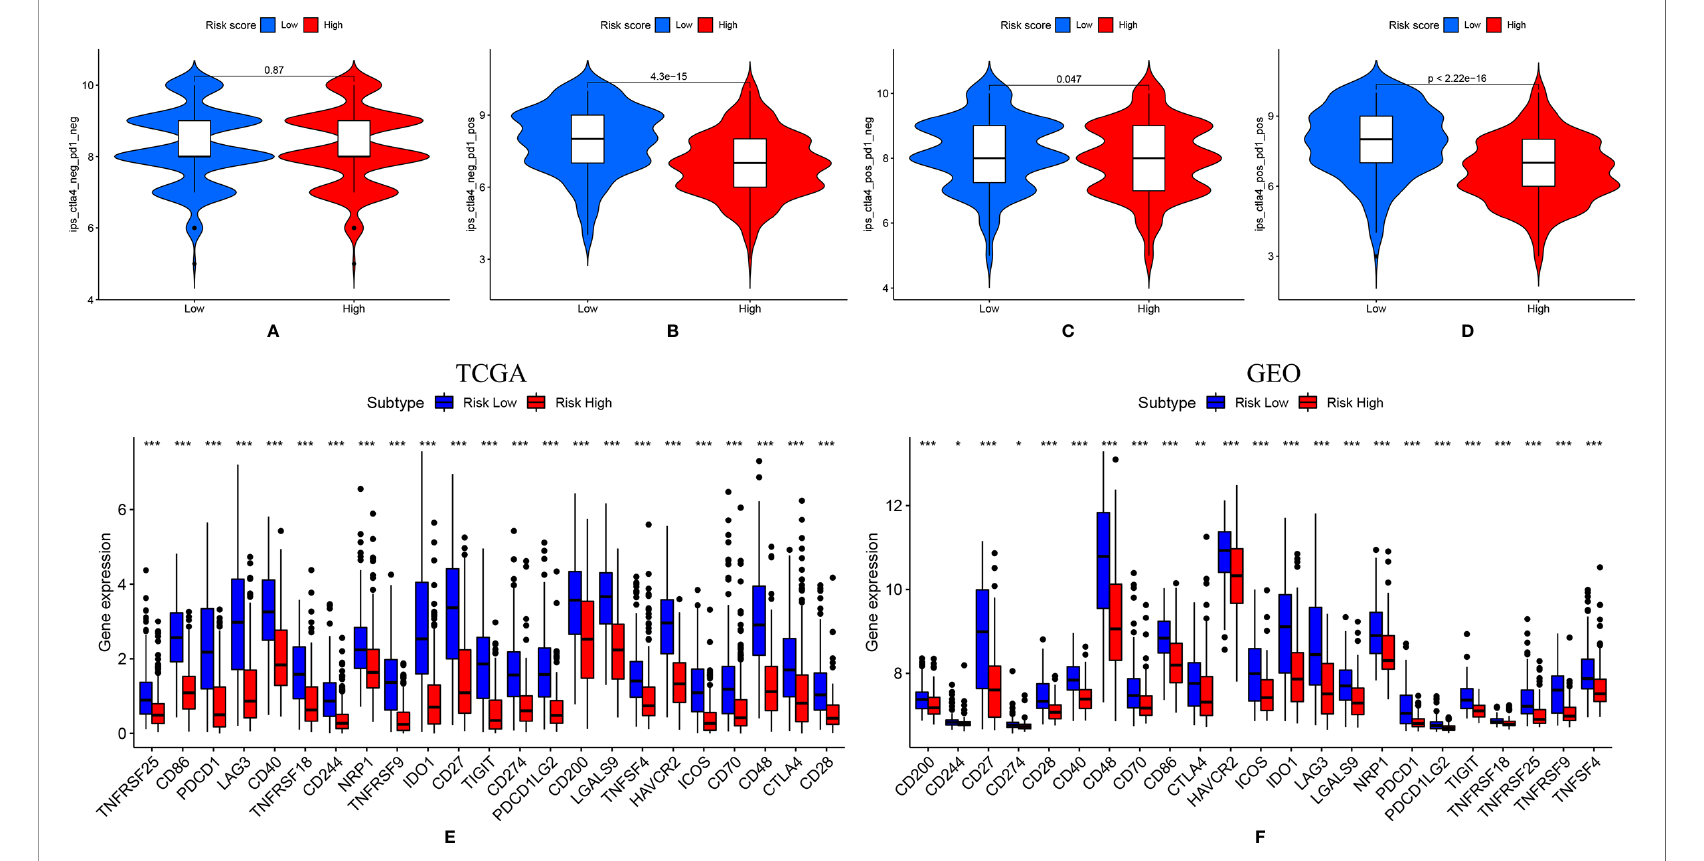
FIGURE 6 | (A-D) Patients were more sensitive to immune checkpoint inhibitor when ether PD1 and CTLA-4 was positively expressed; (E, F) . Immune checkpoint-related genes were highly expressed in the low- risk group. * means P < 0.05, ** means P < 0.01, *** means P <